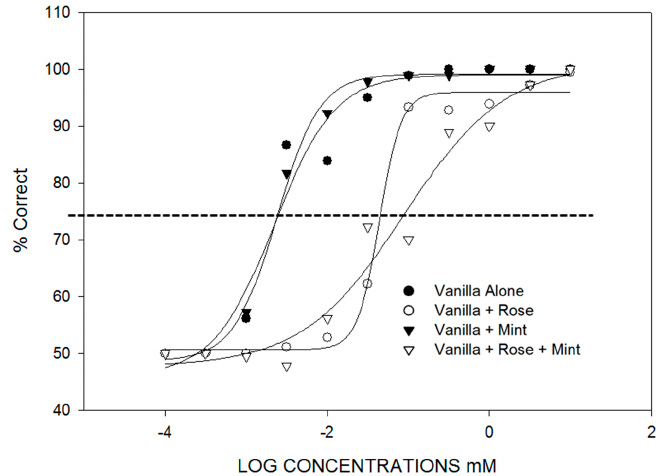
Figure 2. Odor mixture interactions: vanilla plus background. Near-threshold background stimuli affected vanilla odor detection. Background odors were at a constant 0.032 mM concentration. With the exception of l-menthol, vanilla odor detection threshold in mixtures increased by 1 log unit (vanillin + phenethyl-alcohol, p = 0.0001; vanillin + phenethyl − alcohol + l-menthol, p = 0.0001). Vanilla-odor detection threshold possibly increased in presence of background containing rose odor because of olfactory-bulb glomerular competitive mutual suppression. The mint background did not affect vanilla detection. Menthol also elicits a cool sensation. Whether stimuli with trigeminal components behave differently from pure odors in mixtures has not been tested. From